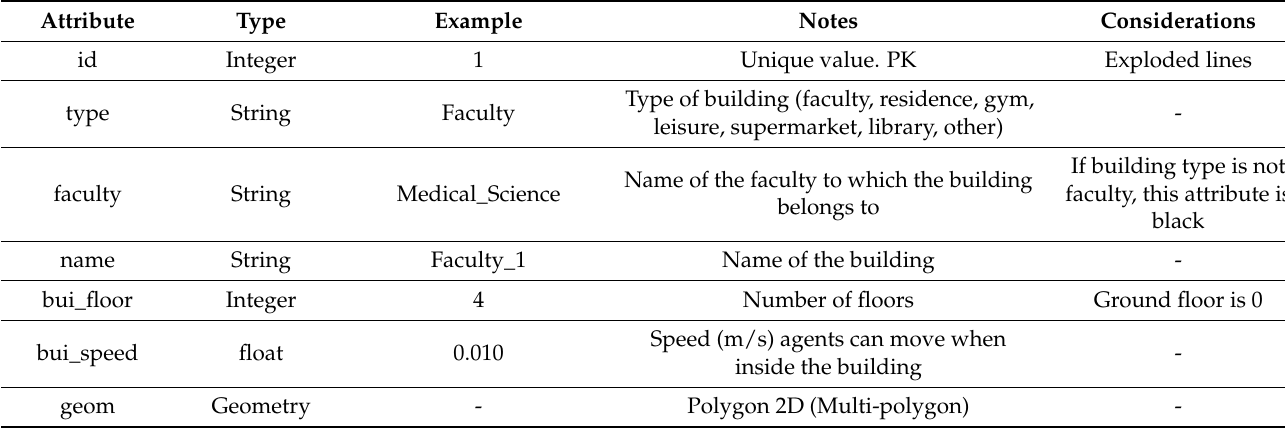
Table A4. GIS attribute table of buildings.